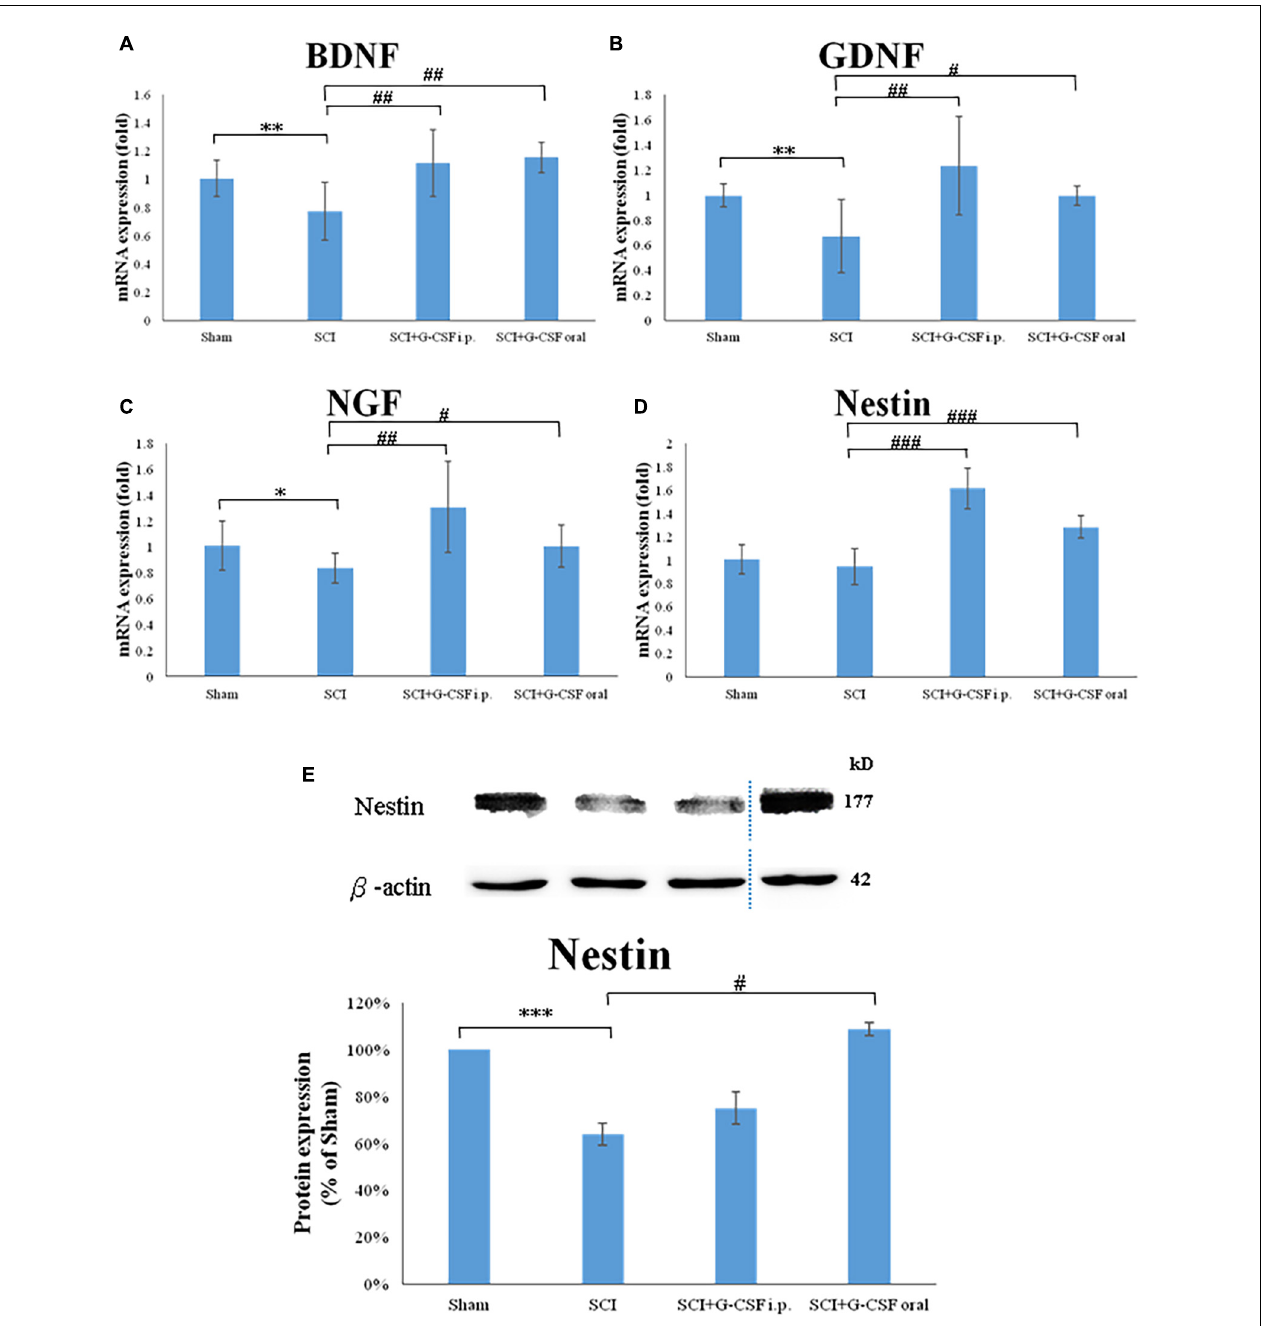
FIGURE 5 | Spinal cord injury (SCI) downregulates the expression of neurotrophic factors and the number of neural stem cells (NSCs) in the olfactory bulb at 8 h post-SCI. (A–D) The mRNA expression levels of BDNF (A) , GDNF (B) , NGF (C) , and Nestin (NSC marker) (D) in the olfactory bulb of the sham control, SCI, SCI + granulocyte colony-stimulating factor (G-CSF) i.p., and SCI + G-CSF oral groups. (E) The protein expression levels of Nestin in the olfactory bulb of the four experimental groups at 8 h post-SCI. The upper panel shows the immunoblot of Nestin (177 kDa). β -Actin (42 kDa) served as an internal control. The lower panel indicates the ratio of Nestin protein band intensity to β -actin protein band intensity relative to the control group. Vertical bars indicate mean ± standard error of mean for mRNA (A–D) or protein expression (E) [ n = 6 in each group for panels (A–E) ]. ∗ P < 0.05, ∗∗ P < 0.01, ∗∗∗ P < 0.001, # P < 0.05, ## P < 0.01, and ### P < 0.001.